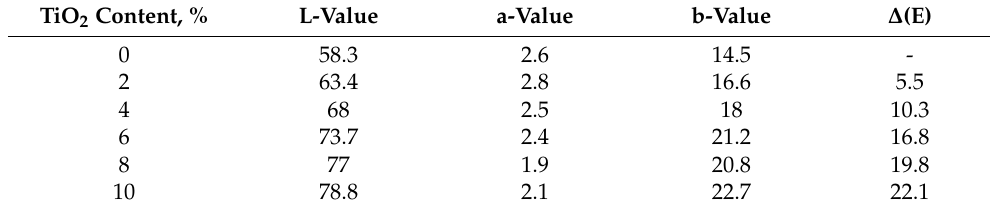
Table 2. Effect of TiO 2 additions on color